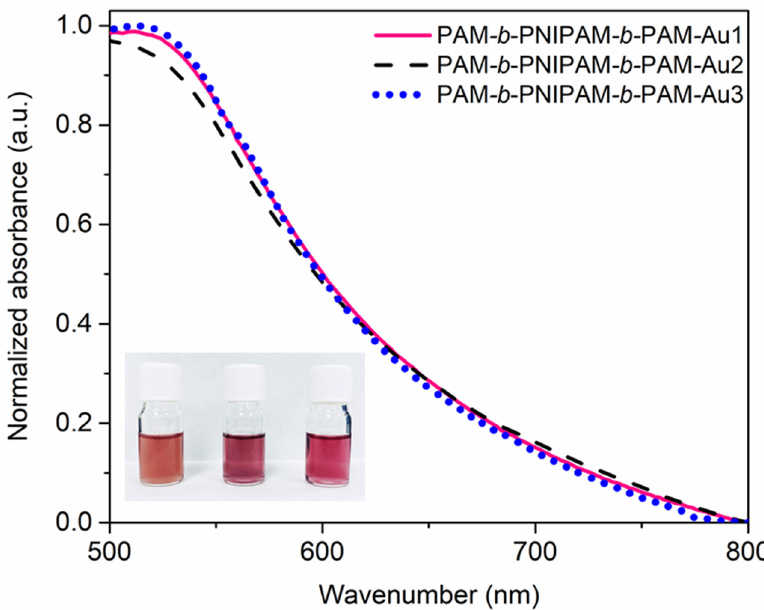
Figure 4. UV-Vis spectra of the nanocomposites in solution. The solutions display different colors associated with the impact of each copolymer on the nanoparticles’ formation. Inset image, from left to right: PAM- b -PNIPAM- b -PAM-Au1, PAM- b -PNIPAM- b -PAM-Au2, and PAM- b -PNIPAM- b -PAM-Au3 solutions.